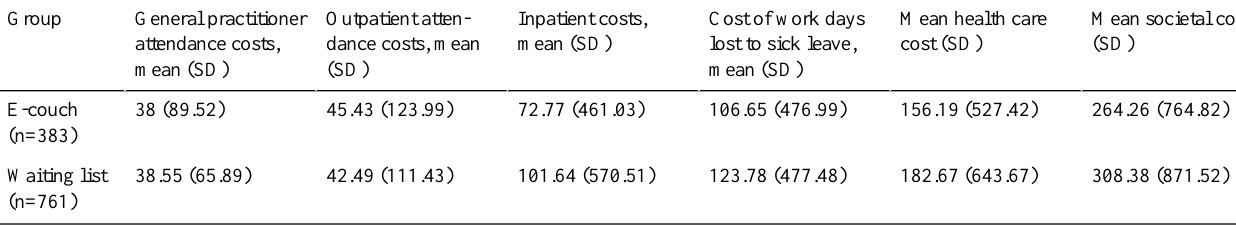
Table 3. Health care utilization and other costs at 6 weeks (£).